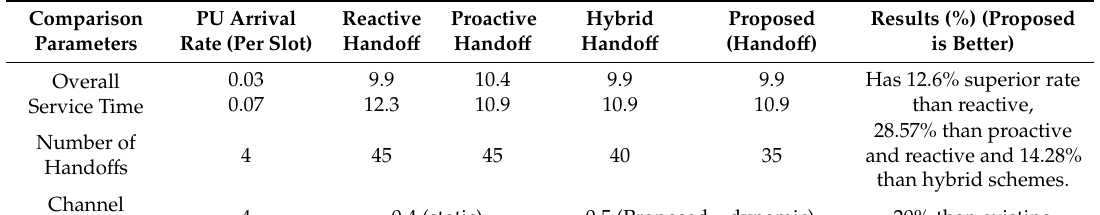
Table 3. Comparison of PUTPOSH and existing schemes based on overall service time, number of hando ff s and channel utilization.